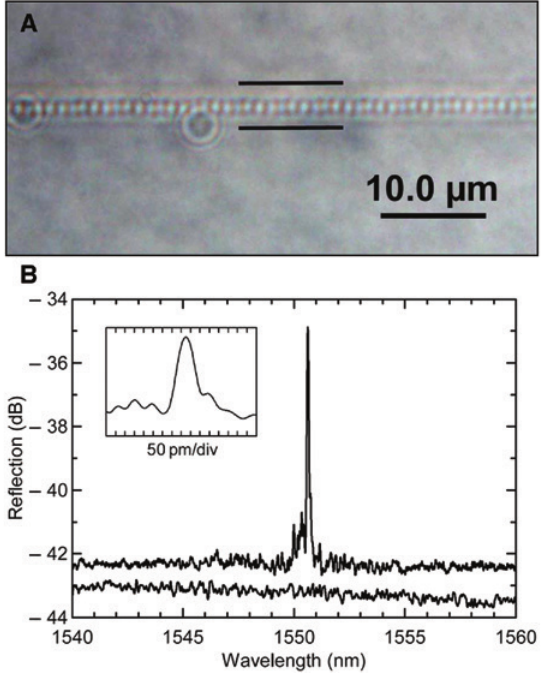
Figure 2: (A) Top-view image of a WBG fabricated in a fused silica sample. As a visual aid, the waveguide edges are indicated by hori- zontal black lines. (B) Reflection spectra from a PbP WBG (top curve) and a waveguide-only structure (bottom curve). The inset shows the WBG curve on an expanded abscissa. Reprinted with permission from